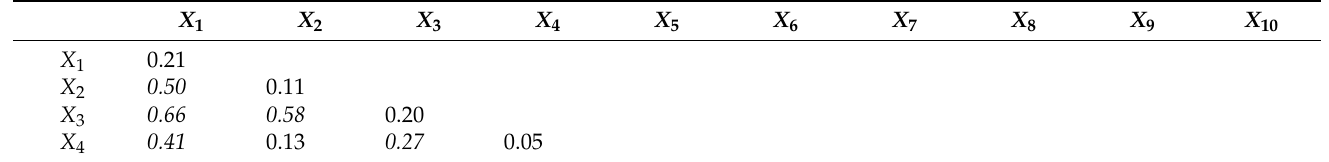
Table 4. Interaction detector of village digitalization